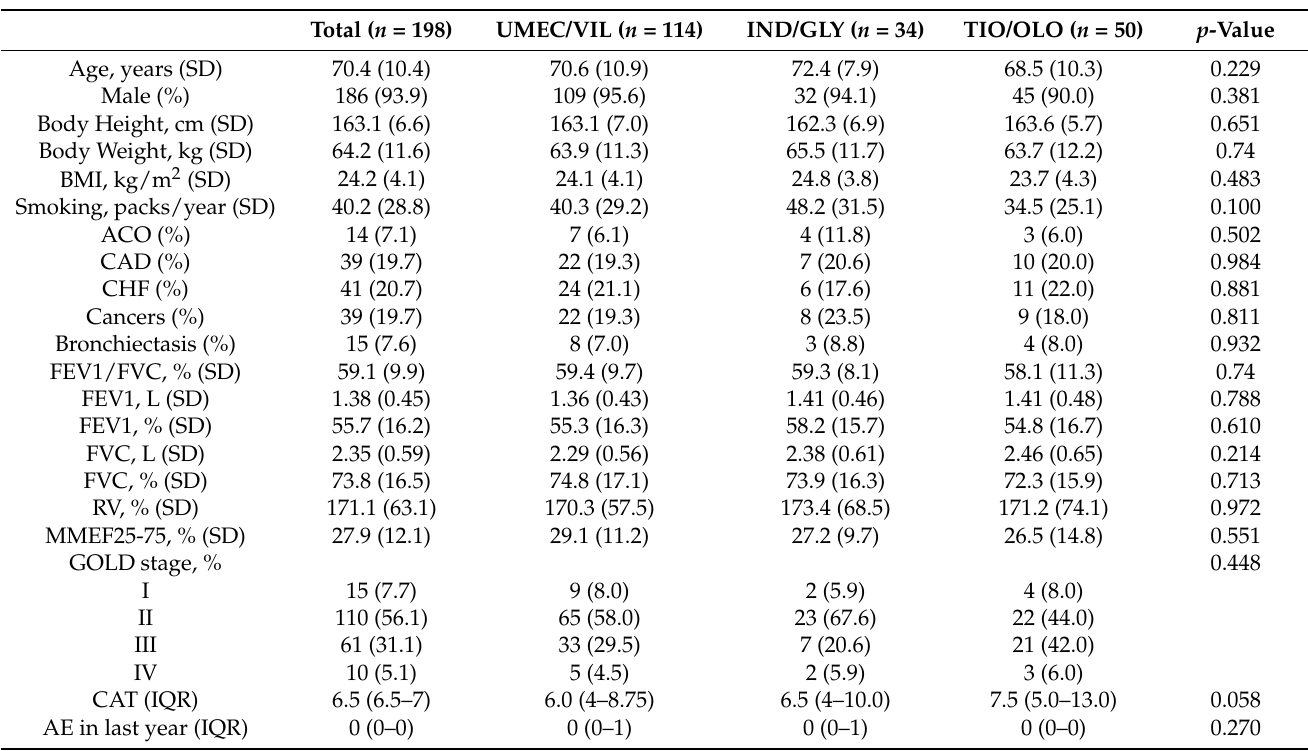
Table 1. Patient